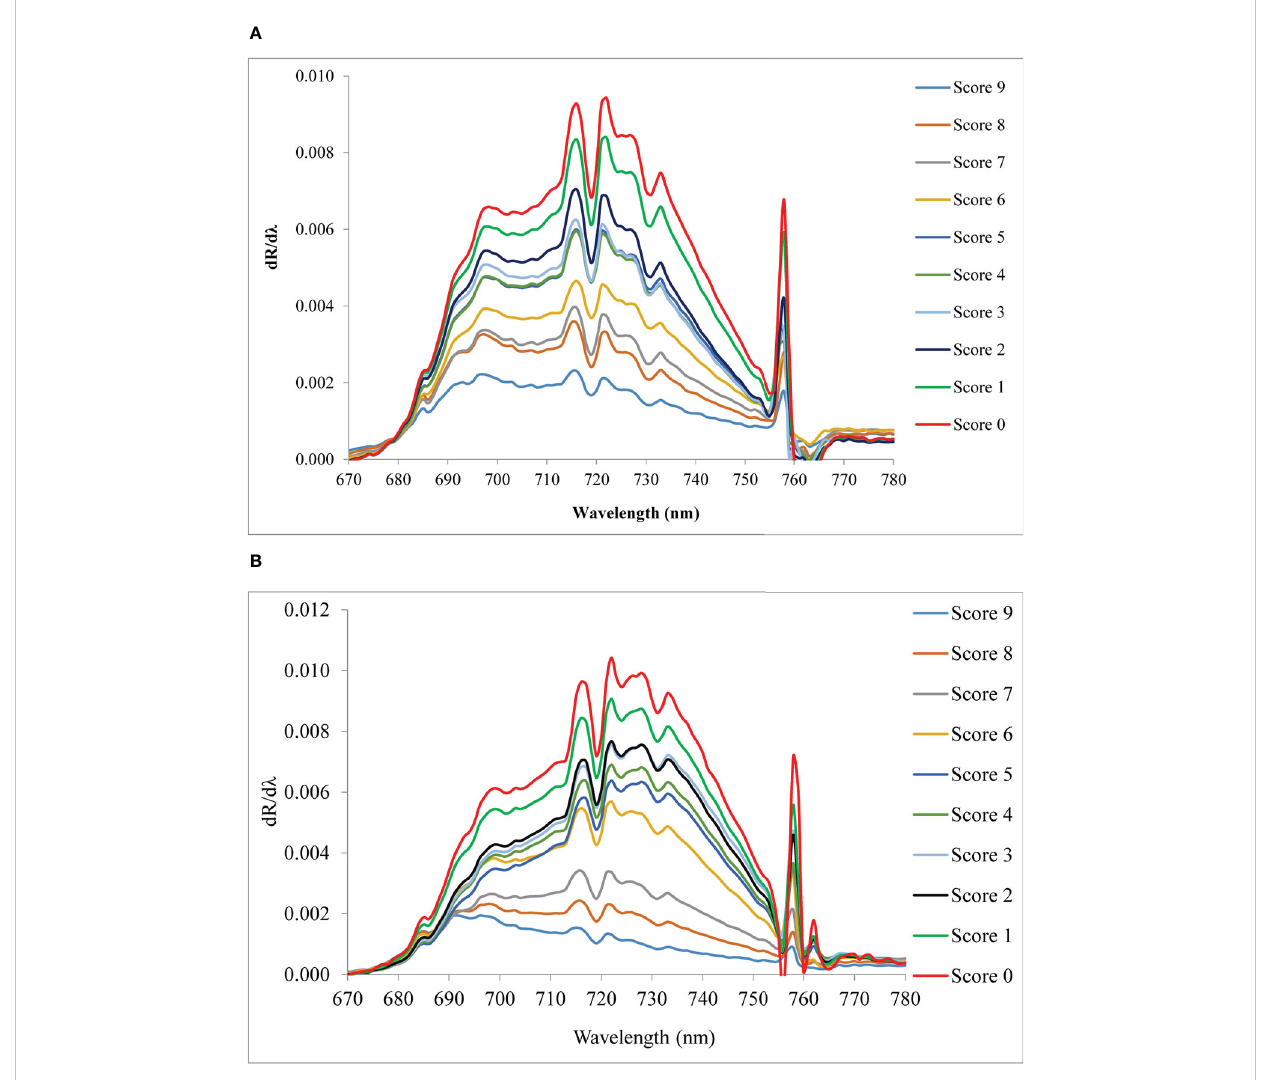
FIGURE 6 Red edge curve of blast infected rice canopy under (A) upland and (B) lowland